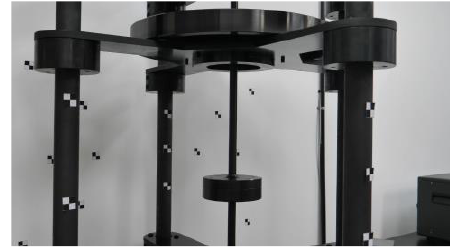
Figure 1. An image used to generate a simulation dataset